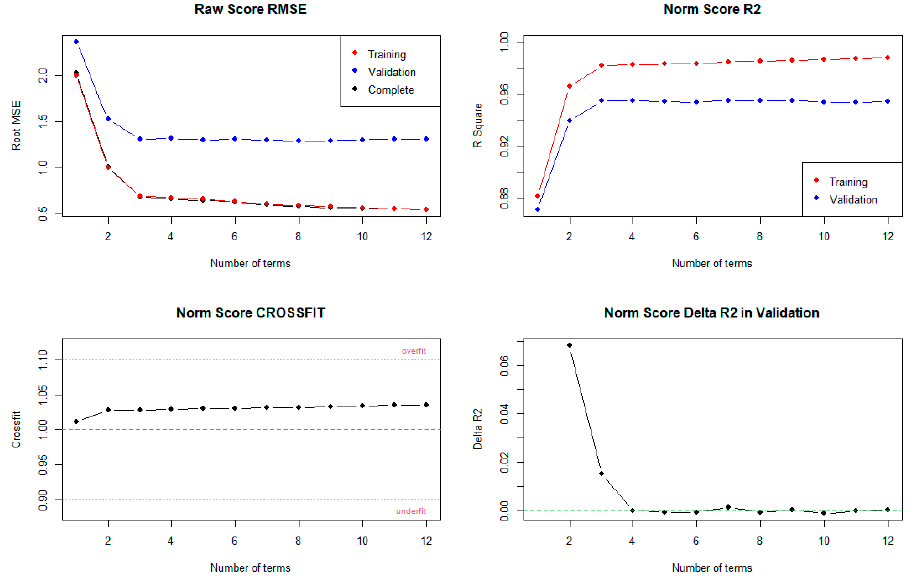
Figure 10. Results of cross validation.